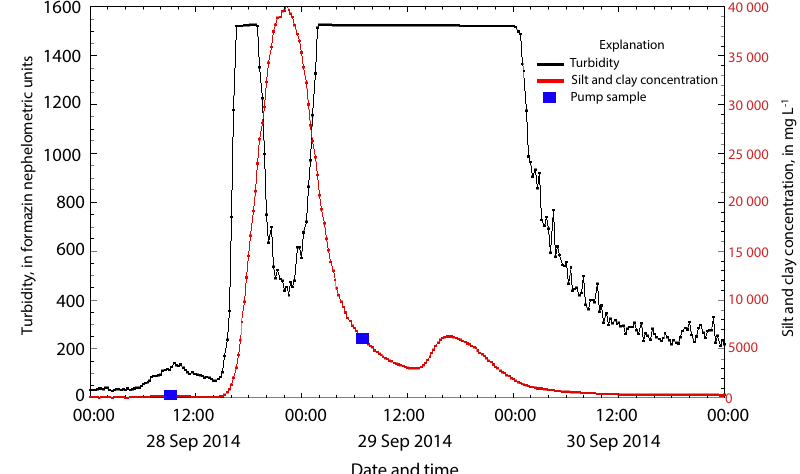
Figure 5. Graph of turbidity (shown in black) and silt-and-clay concentration measured with a 1MHz acoustic-Doppler instrument (shown in red; pump sample silt and clay concentration shown in blue) at the Colorado River near river mile 30 gaging station (Fig. 3) from 28 Septem- ber to 1 October 2014. Turbidity changed from a linear response to increasing silt-and-clay concentration, to a maximum response (i.e., pegged readings), to a negative turbidity response (defined as false low turbidity), which first occurred at 19:15MST on 28 September when the concentration was 26400mgL − 1 . The false low turbidity continued as silt-and-clay concentration increased to a peak of 40100mgL − 1 at 22:15MST on 28 September, and then decreased to 24600mgL − 1 at 01:30MST on 29 September. As this suspended-sediment pulse travelled downstream, a similar false low turbidity was seen at all four downstream gaging stations (Fig.